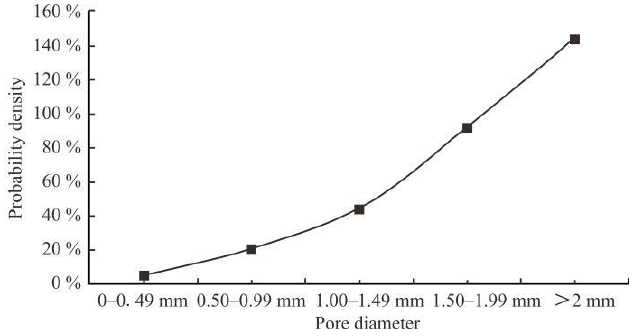
Figure 15. The relationship between pore diameter and probability density.